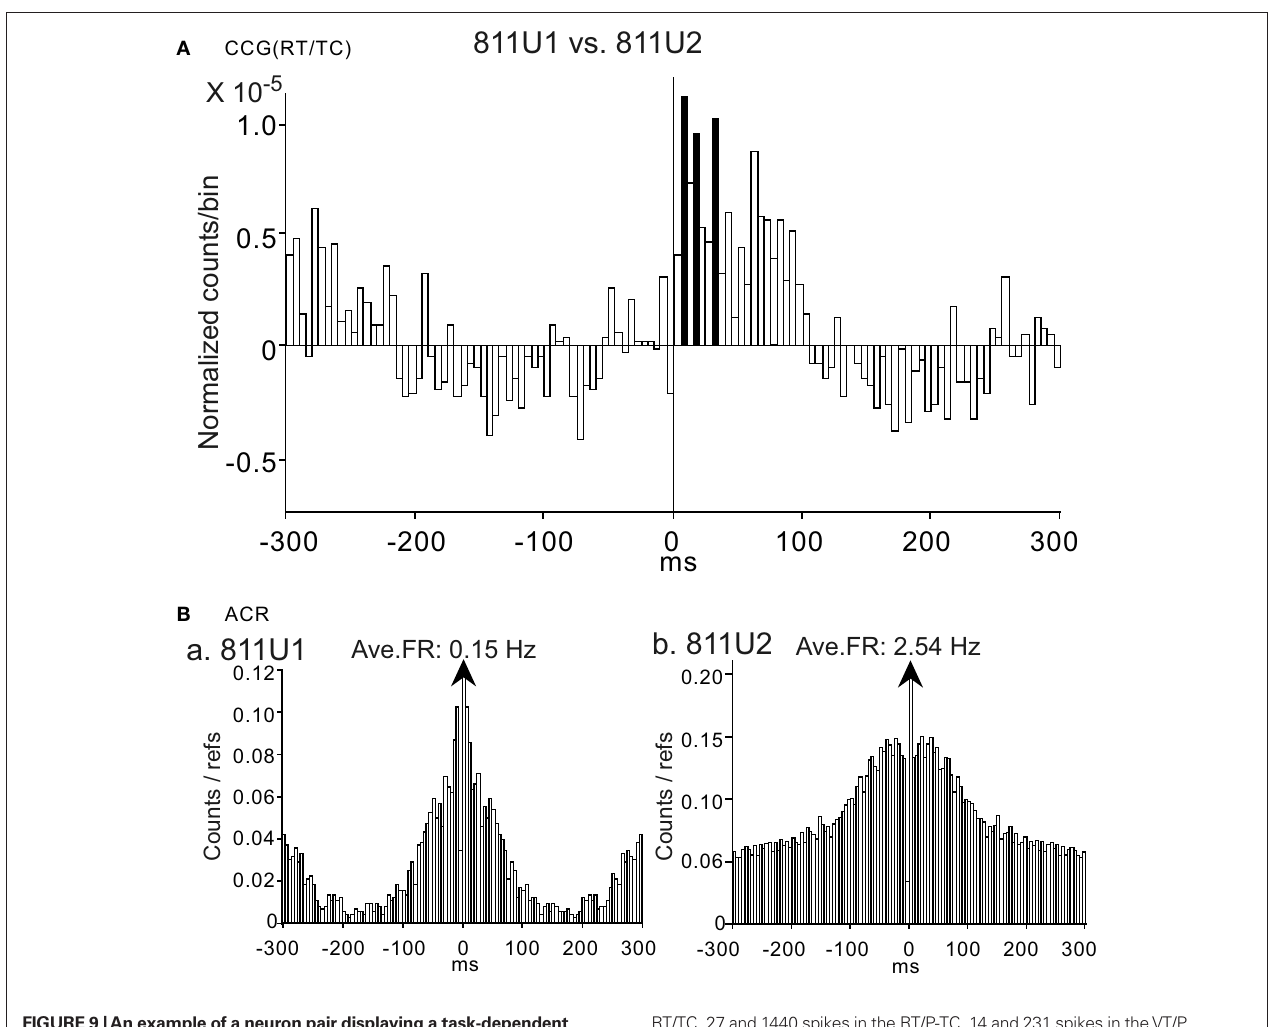
Figure 9 | An example of a neuron pair displaying a task-dependent peak with theta oscillation in the CCgs. (A) Difference CCGs for a pair of CA1 pyramidal neurons (811U1, reference cell; 811U2, target cell) displaying an oscillatory CCG peak in the RT/TC task. Total spikes analyzed in each CCG in each task for neurons 811U1 and 811U2 were 804 and 5131 spikes in the